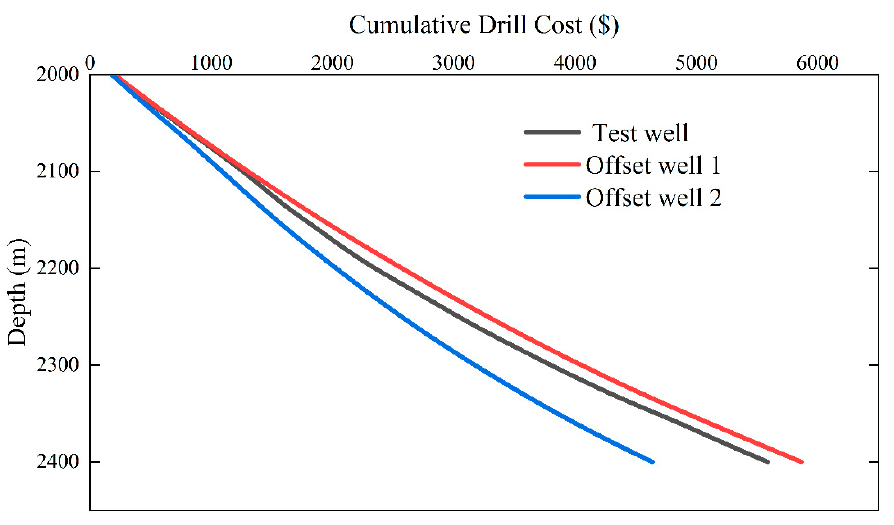
Figure 9. Drilling cost vs. depth.